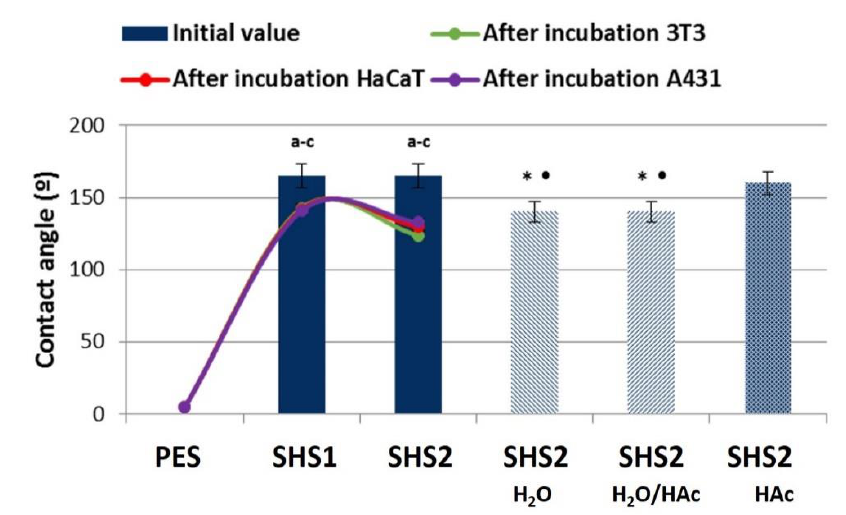
Figure 3. Influence of cell incubation on wettability of the substrates determined by drop shape method. The data corresponds to the average of three independent experiments ± standard deviation. Letter indicates significant di ff erences ( p < 0.001) between the substrate before and after incubation with the three cell lines (a: 3T3; b: HaCaT; and c: A431). * p < 0.001 indicates significant di ff erences between SHS2 before the incubation with cells and • p < 0.001 indicates significant di ff erences between the di ff erent treatments and the treatment with HAc.